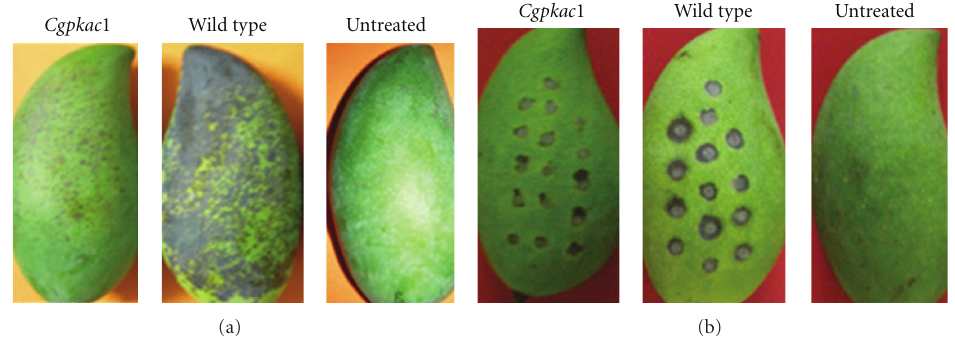
Figure 10: Pathogenicity assays of C. gloeosporioides wild-type strain and Cgpkac1 mutant on unwounded (a) and wounded (b) mango fruits. A 0.5mL conidia suspension containing 10 5 conidia mL − 1 was sprayed onto unwounded fruits, while wounded fruits were inoculated with 20 μ L of conidial suspension. Untreated fruits were treated with sterile distilled water. Anthracnose symptoms were observed daily for ten